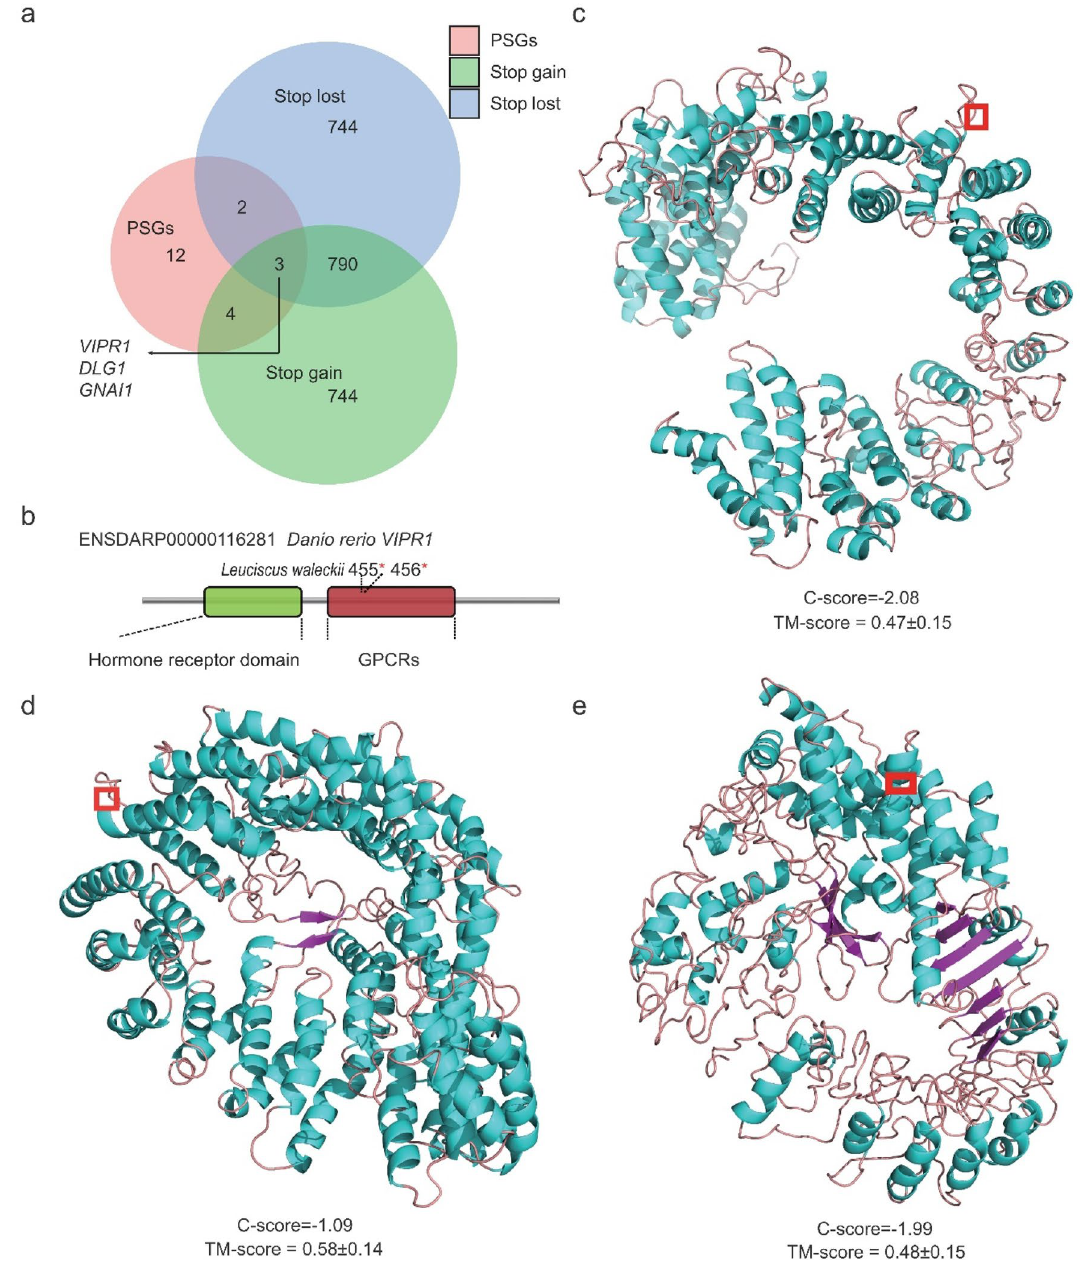
Figure 6. Target genes under selective pressure and differential VIPR1 protein structure in Amur ide ecotypes. ( a ) Venn diagram showing unique and overlapping genes among the PSGs and genes with stop-lost and stop- gained SNPs in DL, GG, and SH. ( b ) Structural analysis of the two positively selected sites of VIPR1. The protein coordinate is based on Ensembl ID ENSDARP00000116281. The lower panel shows the Pfam domains of the protein. The red stars indicate two sites (455th and 456th) that are essential for ligand binding. ( c – e ) Spatial distribution of positively selected sites in the 3D structure for Amur ide VIPR1. Three-dimensional views of VIPR1 proteins in DL ( c ), GG ( d ) and SH ( e ) highlight positively selected sites (455th and 456th) colored in the red rectangle